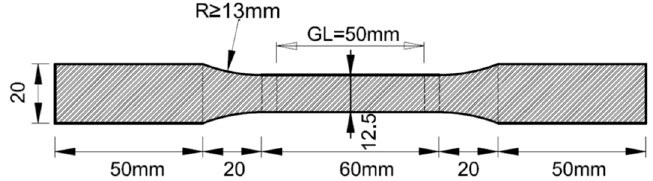
Figure 2. Standard tensile specimens of steel sheet.